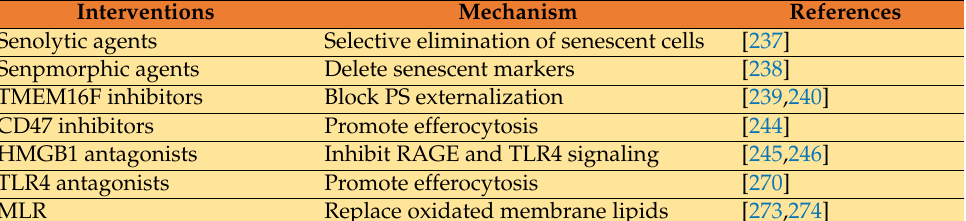
Table 1. Biological barrier